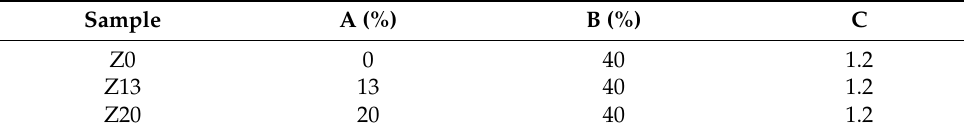
Table 7. Mechanism analysis test group.